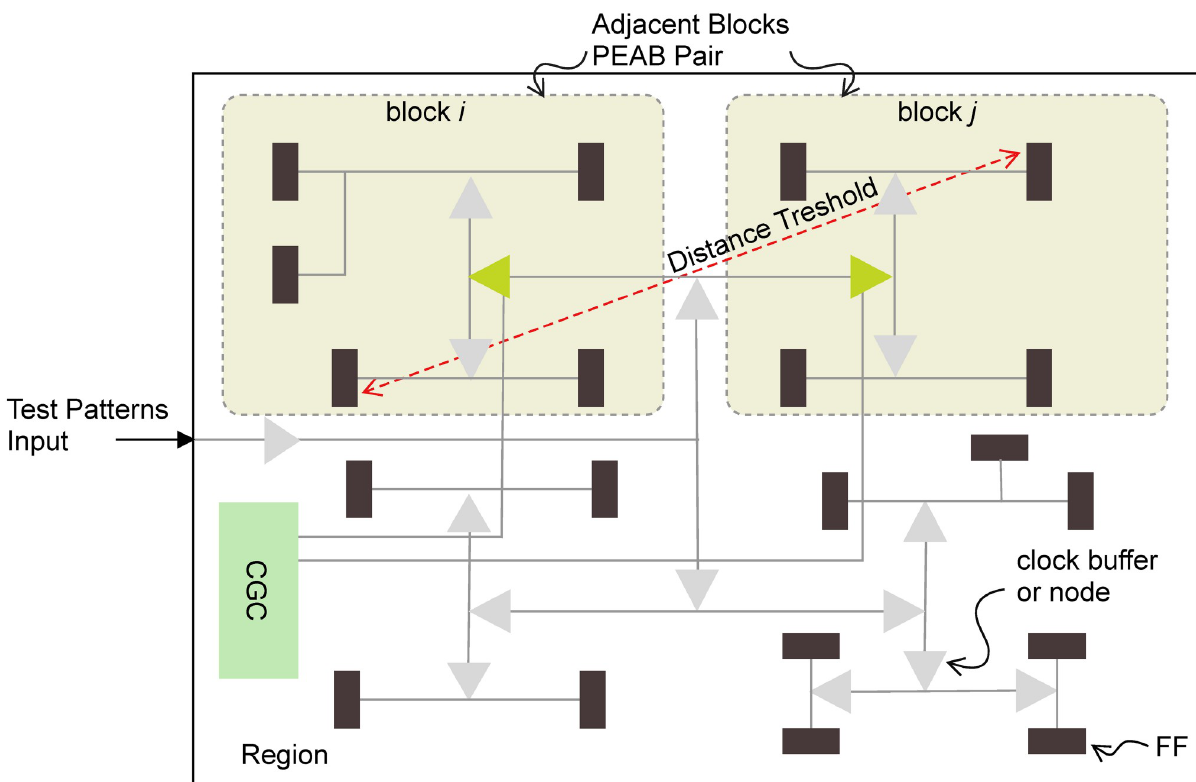
Fig 2. Definition of nodes, adjacent blocks, region, distance threshold and PEAB